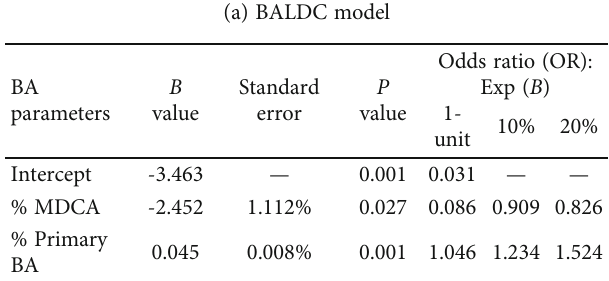
Table 4: Univariate logistic regression analyses for the prediction of developing ascites in the entire liver-patient population based on demographics and non-BA parameters.